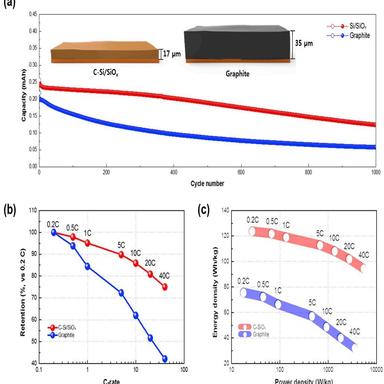
(a) Cycle performance of the LIC full cells prepared by the pre-lithiated C-coated Si/SiOx nanosphere electrode and pre-lithiated graphite electrode at a constant current density of 10C during 1000 cycles, (b) rate capabilities of the LIC full cells at different current densities of 0.2, 0.5, 1, 5, 10, 20, 40C (1C ¼ 85 mA g 1 ), and (c) Ragone plots for the LIC full cells according to different current densities.